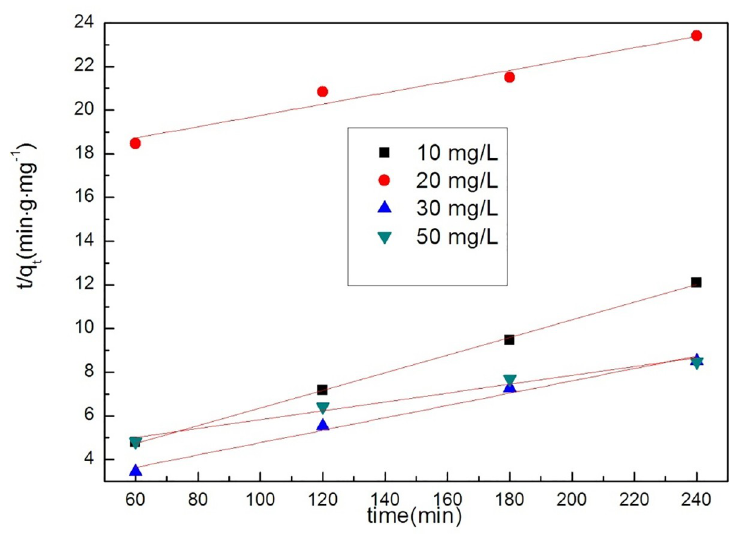
Fig 7. The Pseudo-second-order kinetic model of GO/MOFs on